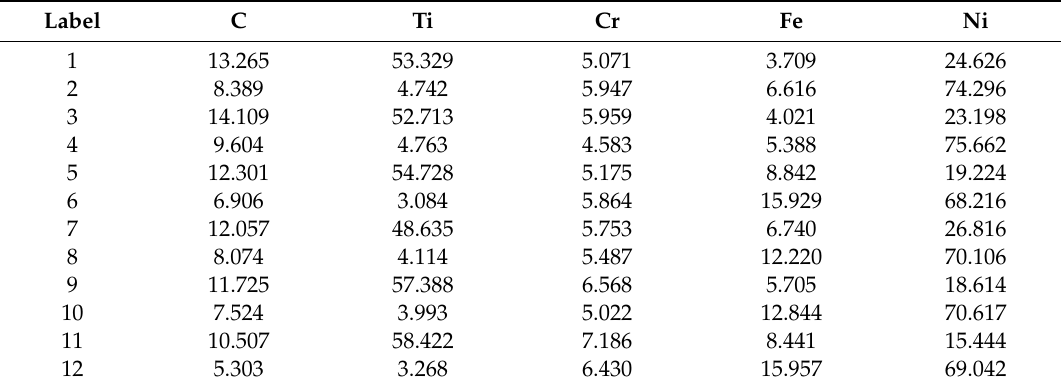
Figure 8. Friction and wear diagram of cladding layer with different laser powers: ( a ) 2# sample: 1.4 kW, 7 mm/s, 1000 L/h, 20% TiC; ( b ) 4# sample: 1.2 kW, 7 mm/s, 1000 L/h, 20% TiC. Table 6. The element content of cladding layers at different laser powers (Labels 1–6 belong to 2# sample, Labels 7–12 belong to 4# sample).